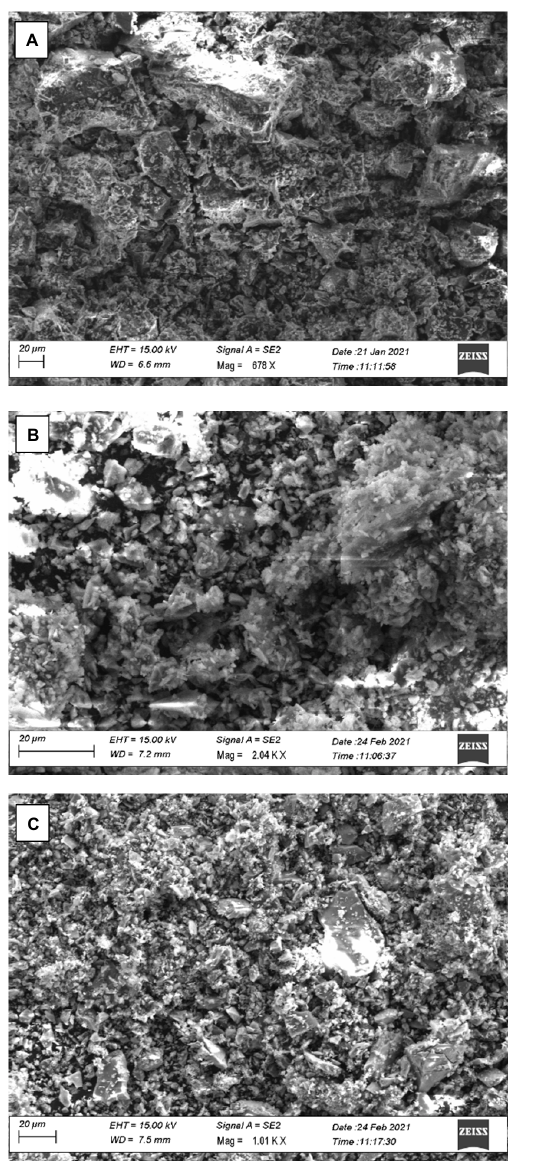
Figure 1. Isothermal data (left) and pore size distributions (right) of catalyst material: ( A ) pristine, ( B ) after fourth cycle, and ( C ) after fourth cycle and thermic treatment at 400 °C.